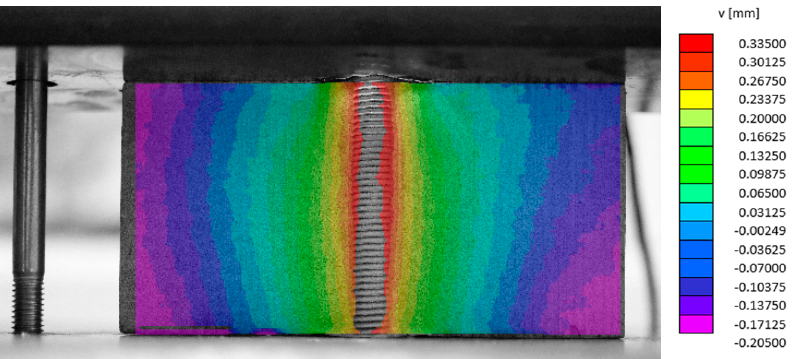
Figure 7. Example of the typical shear strain distribution along the rod, as obtained by digital image correlation